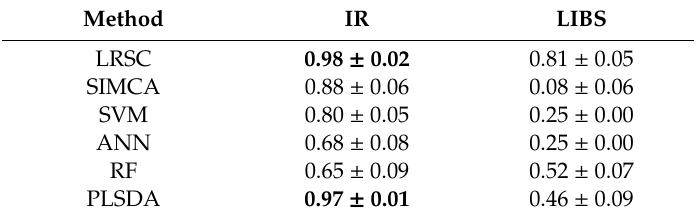
Figure 3. Spectral data of Tegillarca granosa polluted by different heavy metals. ( a ) Infrared spectral data. ( b ) Laser-induced breakdown spectral LIBS data. Table 1. Recognition rates of different methods using infrared spectral data and LIBS data.